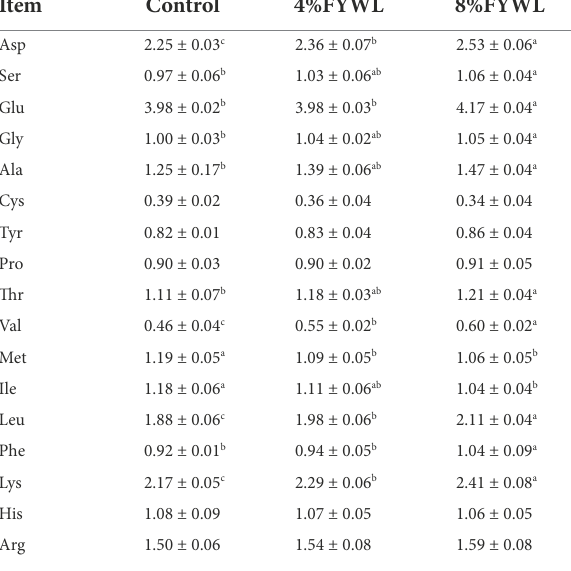
TABLE 6 Effect of FYWL on amino acid content of meat.